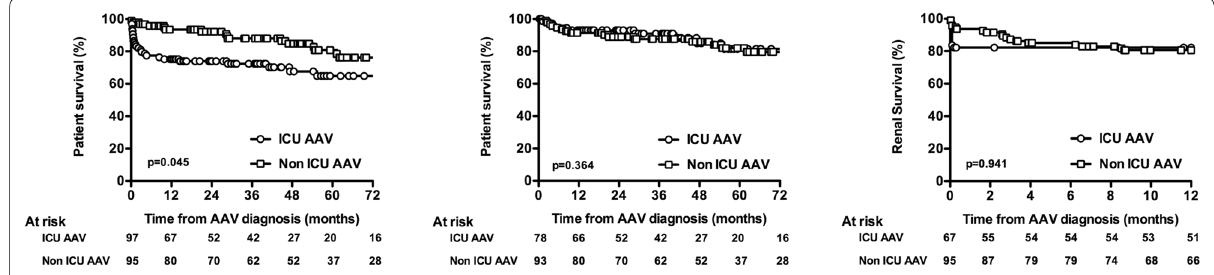
Fig. 1 a Survival of ICU and non‑ICU‑AAV patients and b survival of patients who survived to the first hospital stay. c Renal survival of ICU and non‑ ICU patients. Survivals were compared using the log‑rank